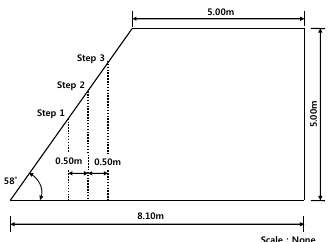
Figure 3. Cross-section diagram of the model slope. Figure 4. Construction of the model slope.